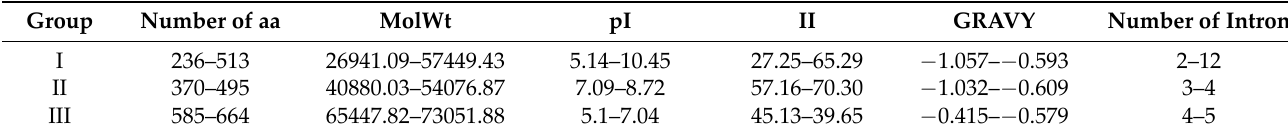
Table 1. Physicochemical properties of CsGLKs.